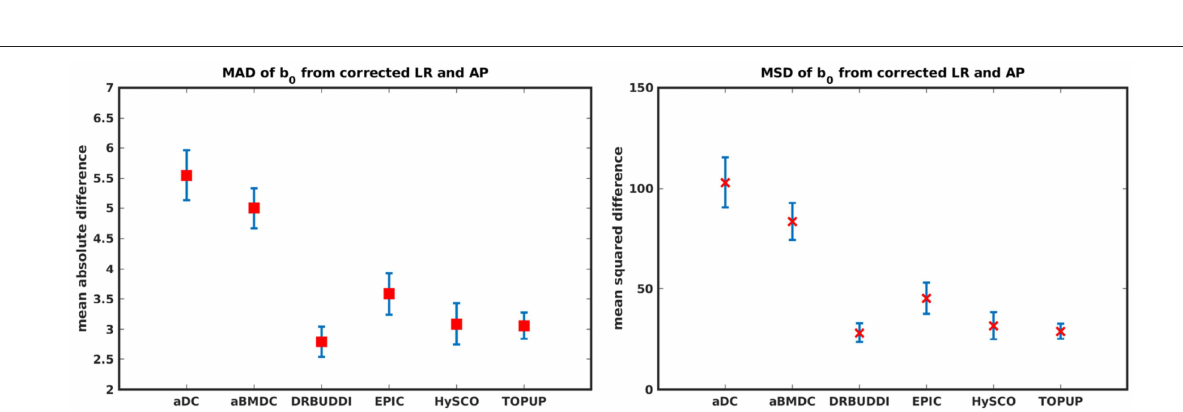
Frontiers in Neuroinformatics |